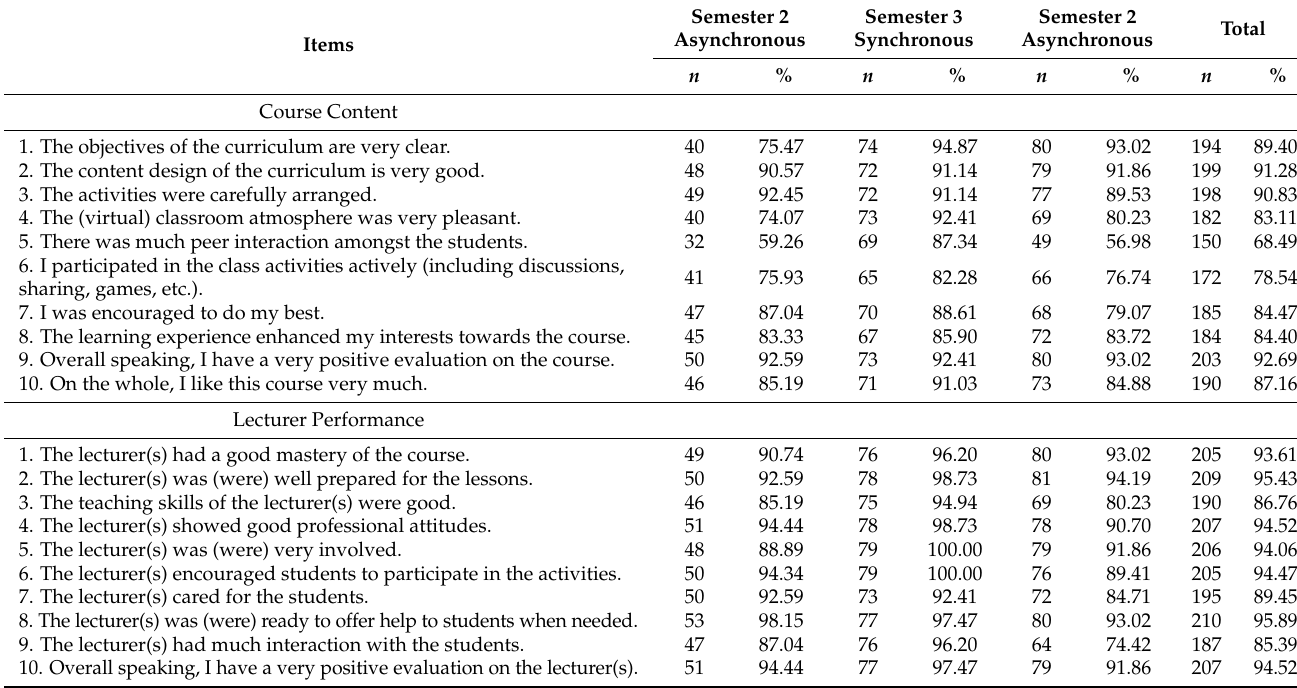
Table 3. Positive responses (options 4–5) regarding participants’ evaluations on the course content and lecturer performance.